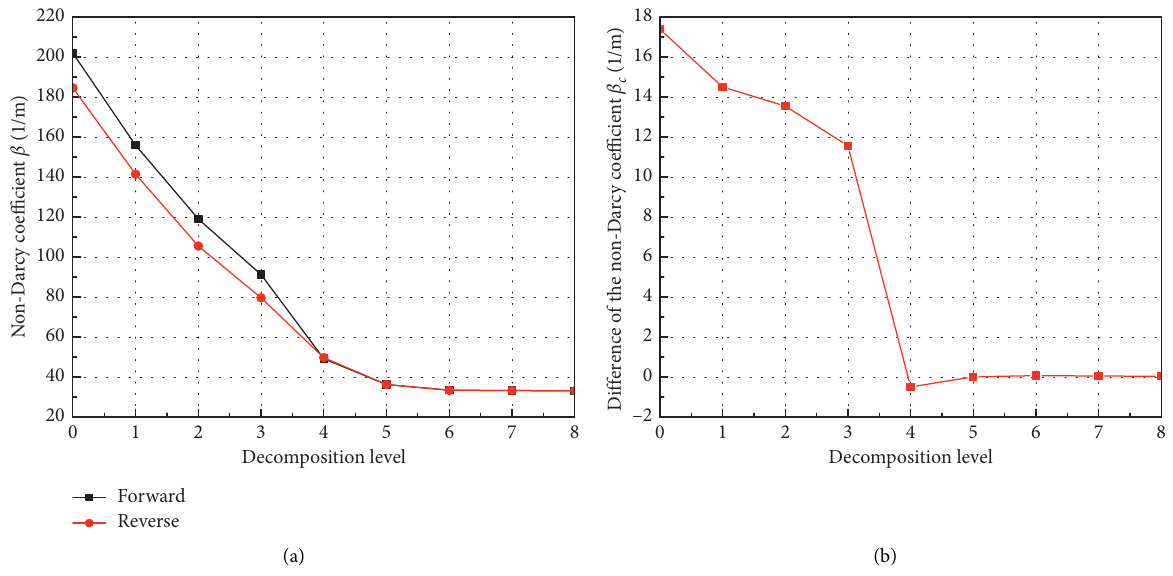
Figure 7: The correlation between Non-Darcy coefficients β in the forward and reverse directions with the decomposition level: (a) non- Darcy coefficient β ; (b) difference of the non-Darcy coefficient β C